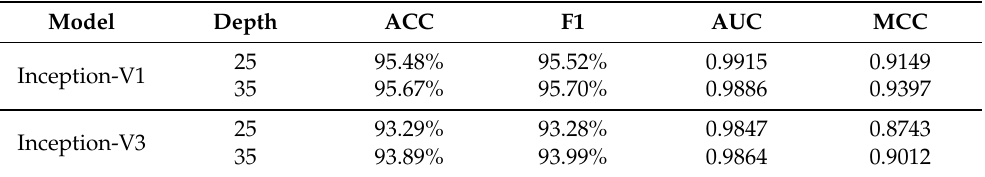
Table 5. Individual models—Overall performance for three-way classification models in terms of accuracy, F1-score, AUC, and MCC for both Inception-V1 and Inception-V3 for varying CT scan depths of 25 and 35 slices.